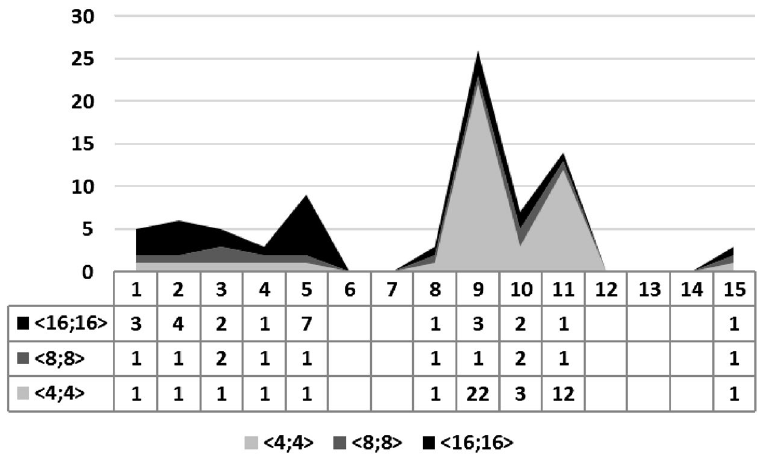
Figure 8. We illustrate the area chart for our experiments considering both settling time and overshoot under different FWL formats ( (cid:31) 4, 4 (cid:30) , (cid:31) 8, 8 (cid:30) , and (cid:31) 16, 16 (cid:30) ) and the number of attempts to synthesis the digital controllers from 1 to 15. As we can observe, the FWL format directly influences the number of attempts to synthesize these digital controllers, considering settling time and overshoot as